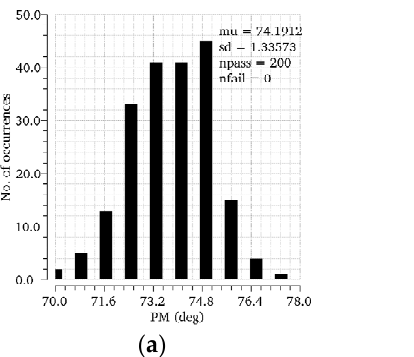
( a ) ( b ) ( a ) ( b ) Figure 8. Monte − Carlo simulations when I Load = 0 and C L = 100 pF. ( a ) PM, ( b ) GM. Table 1. Simulation results over PVT variation for the best, mean, and worst stability cases. Worst Mean Best PM(deg) 47.8 69.7 77.8 GM(dB) 9.1 16.8 33.1 Including MOS tt/ss/ff/snfp/fnsp corners, R and C tt/ss/ff corners, temperature − 40/27/120 °C, and